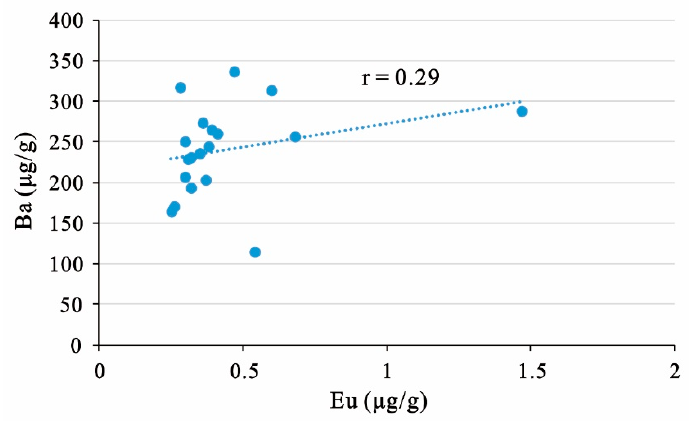
Figure 5. Relationship between Eu and Ba in the No. 2 1 coal from the Hebi No. 6 mine. The REY concentrations of the No. 2 1 coal samples (from 42.98 to 186.57 μ g/g, 97.99 μ g/g